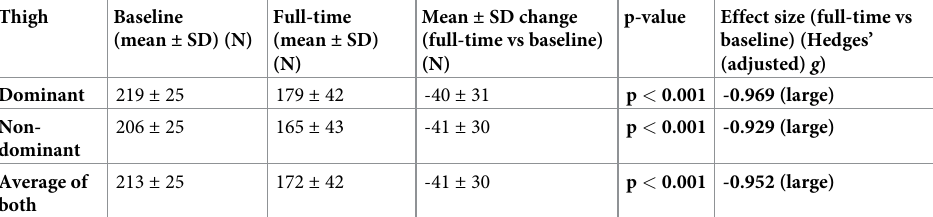
Table 2. Changes in the eccentric maximal hamstring strength were measured by handheld dynamometry (n =